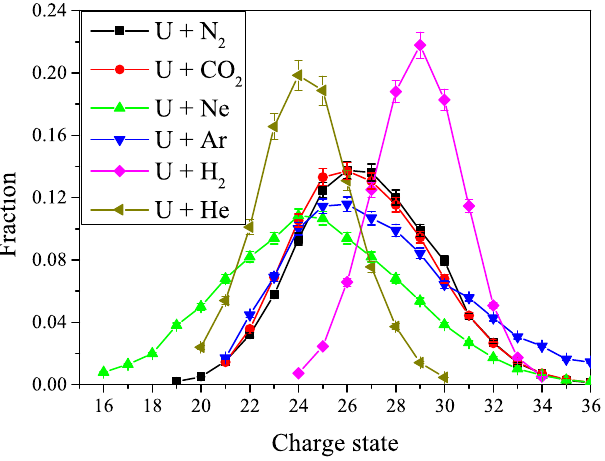
FIG. 8. Saturated charge state distributions for 238 U on N 2 , CO 2 , Ne, and Ar gas at 1 . 4 MeV = u. The saturated charge state distributions for 238 U on H 2 and He (see Fig. 5) are shown for comparison.